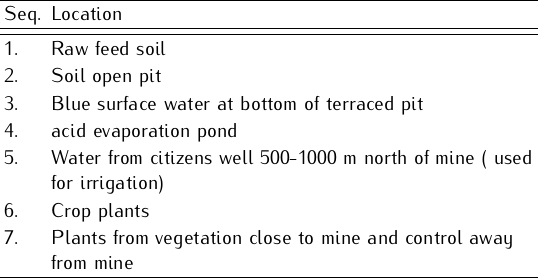
Table 1. Sampling